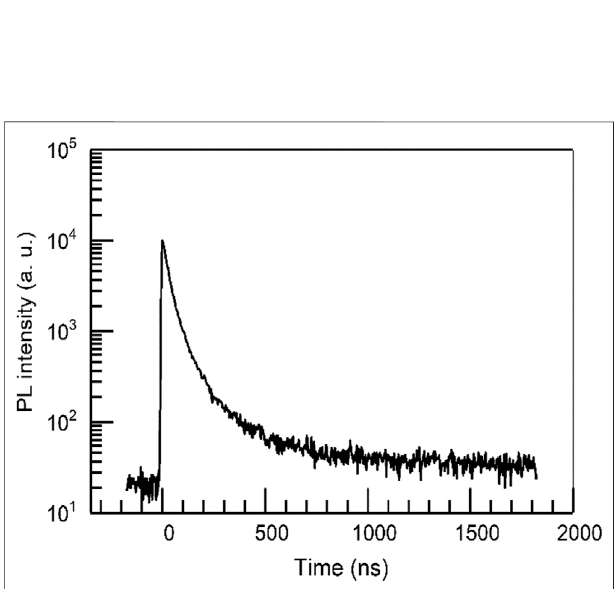
FIGURE 5 | Time-resolved transient PL curve of MA 0.6 FA 0.4 PbI 2.8 Br 0.2 perovskite fi